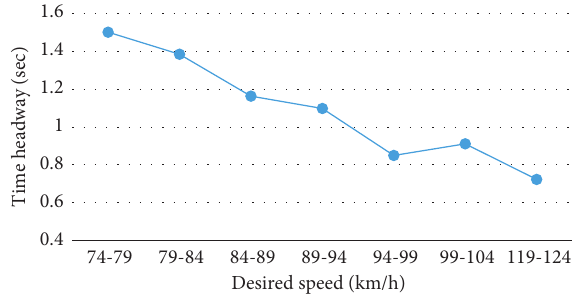
Figure 6: Relationship between TH and DS of drivers in steady- state CF. Table 6: Pairwise Pearson correlations of age-TH and DS-TH.